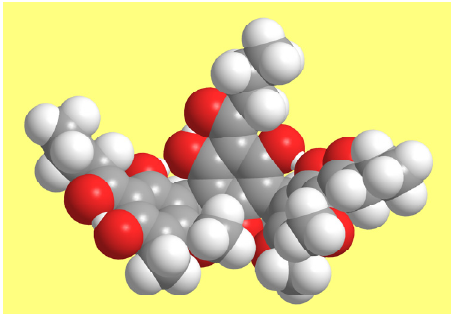
Figure 6. Illustration of the ‘crowding’ of methyl groups in the lower rim of the half-bowl-shaped conformers of trimeric acylphloroglucinols in which the OHs at C4 and C4 ″ are replaced by OCH 3 groups and methyl groups are present at C5 and C3 ″ . The figure shows the 1-y-in-in conformer of T9-M5,3 ″ -ET6,4 ″ .